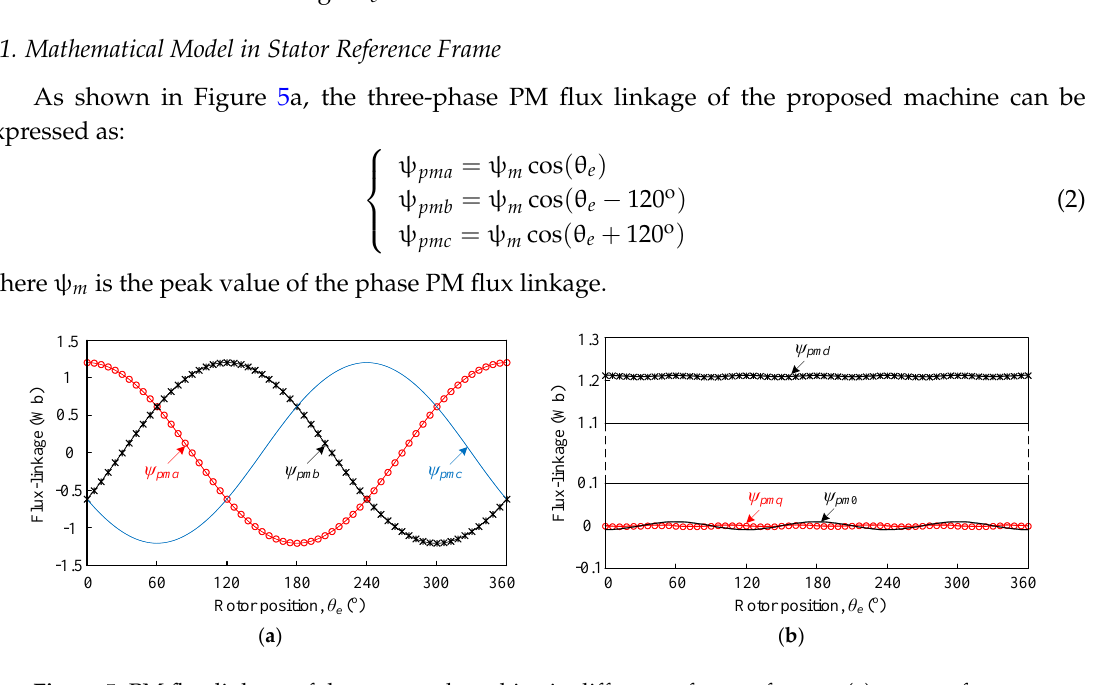
Figure 5. PM flux linkage of the proposed machine in different reference frames: ( a ) stator reference frame; ( b ) d-q reference frame.